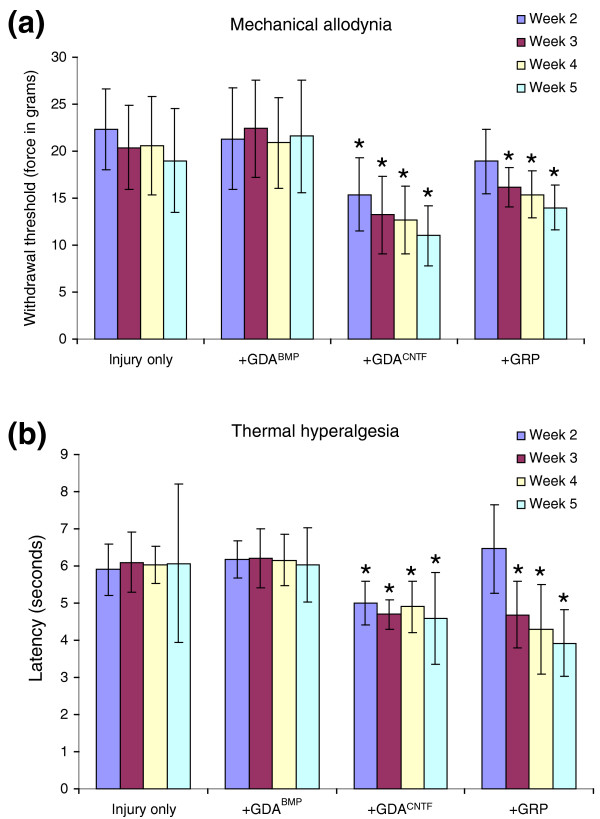
Von Frey filament and hot-plate analysis of mechanical and thermal allodynia. (a) Withdrawal threshold of the right front paw to a mechanical stimulus (force in grams). Measurements were made on GRP- or GDA-transplanted and injured control animals at 2, 3, 4 and 5 weeks after dorsolateral funiculus injury/transplantation. (b) Latency (in seconds) to paw withdrawal from a heat source. Note that injury alone and GDABMP transplantation do not induce statistically significant mechanical or thermal allodynia at any time point. However, the mechanical threshold and latency to withdrawal from a heat source are significantly lower in GDACNTF- and GRP-transplanted rats beginning at 2 and 3 weeks, respectively, post-injury/transplantation. Asterisks denote a statistical difference from time-matched control animals (two-way repeated measures, ANOVA, p < 0.05). Error bars represent 1 SD.